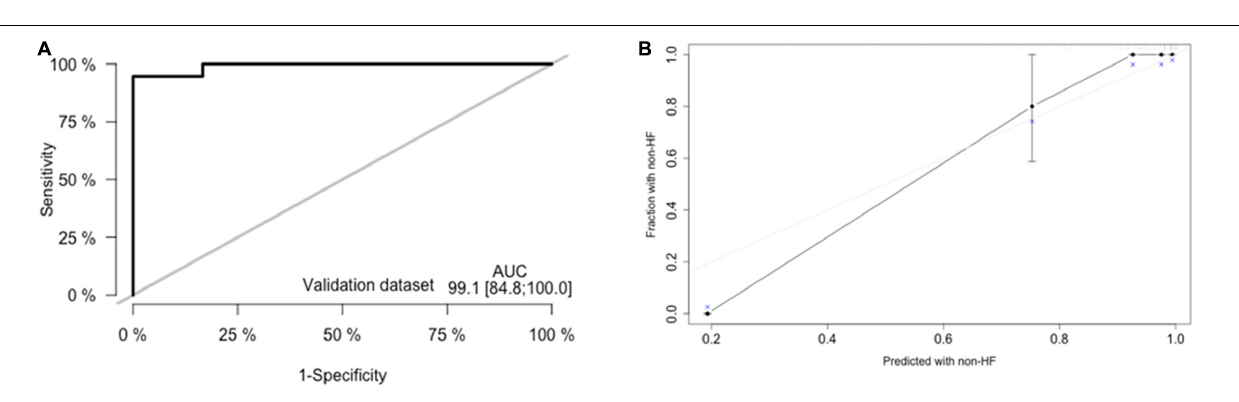
FIGURE 6 | External validation of nomogram in validation dataset. (A) Discrimination: Area under the curve (AUC) of the receiver operating characteristic (ROC) curve analysis was 0.948 (95% CI: 0.885–1.000, p < 0.001). (B) Calibration